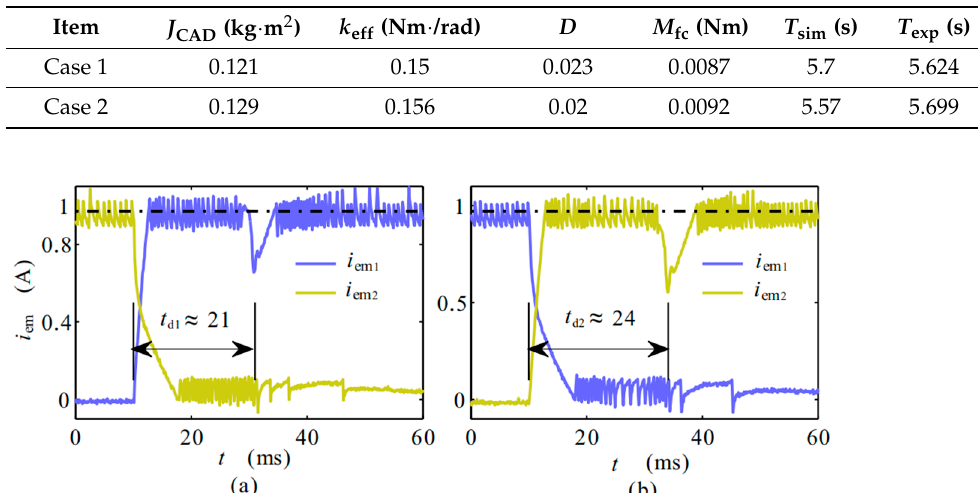
Table 1. Results of parameter identification.